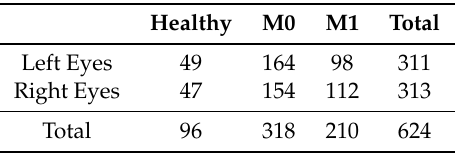
Table 2. Number of eyes used for the analysis of overall retinal thickness in the full dataset from EDDMO study.